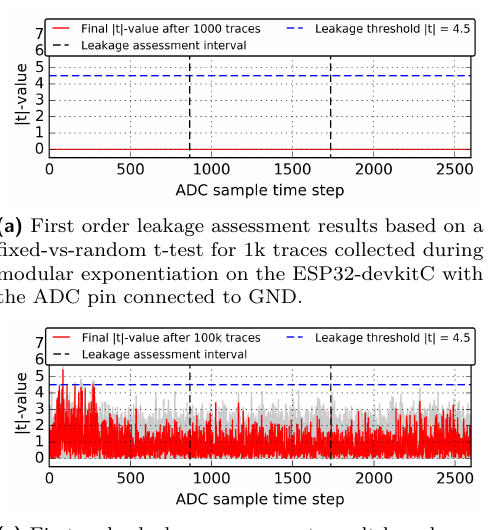
Figure 14: Results of Leakage Assessments on ESP32-devkitC for mbedTLS modular